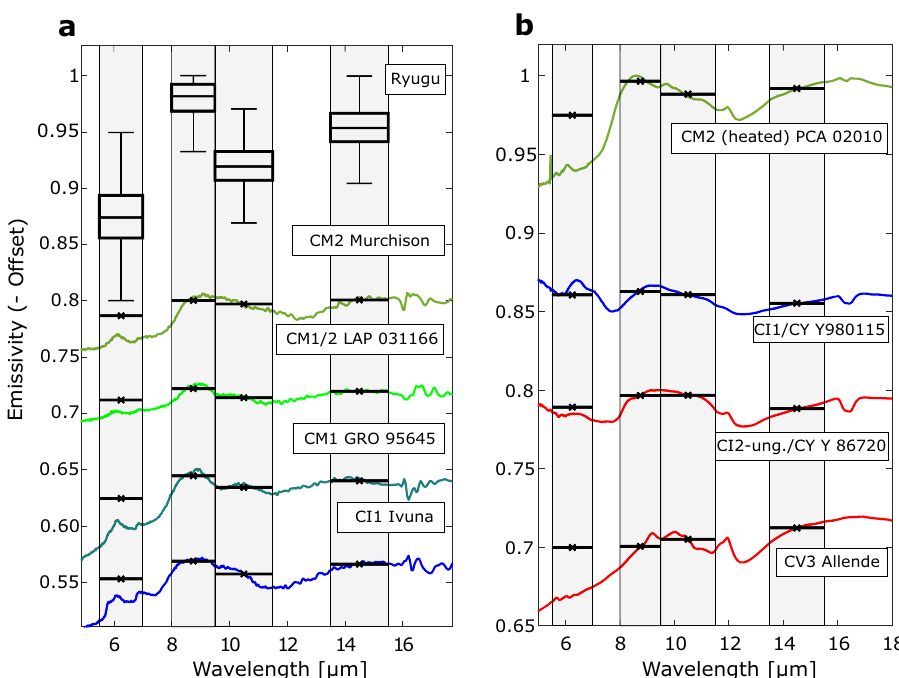
Fig. 7 Comparison of derived emissivity of Ryugu compared to inverted re fl ectance spectra of powdered carbonaceous chondrites. a As in Fig. 5, boxplots of the emissivity estimates for Ryugu in comparison to examples of carbonaceous chondrites, where horizontal lines represent the average emissivity within a MARA band weighted by the instrument function. The four spectra are highly aqueously altered chondrites with increasing degrees of alteration 45 . b Emissivity spectra of heated and aqueously altered carbonaceous chondrites 19 . Shown are CM2 PCA 02010 which was exposed to severe heating after being aqueously altered, as well as two CY chondrites, the moderately heated Y 980115 and the severely heated Y 86720. Below is a spectrum of CV3 Allende 47 . The colours of the spectra were chosen to match the corresponding symbols in Fig. 6. Source data are provided as a Source Data fi